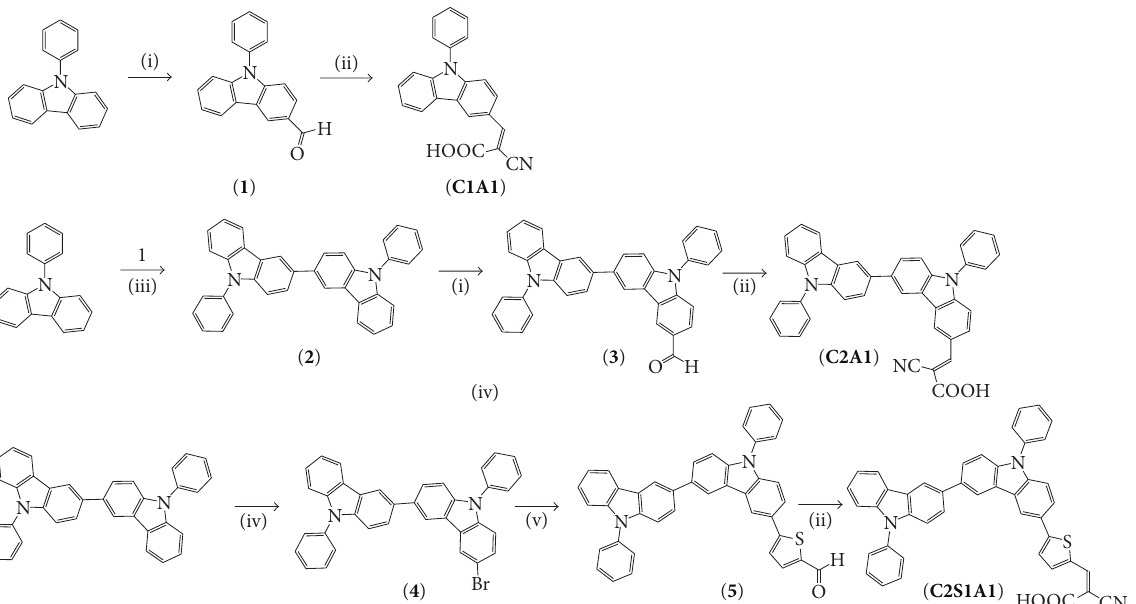
Scheme 1: Synthetic procedure of organic dyes. (i) DMF, POCl 3 , and 1,2-dichloroethane, reflux; (ii) cyanoacetic acid, piperidine, and CH 3 CN, reflux; (iii) FeCl 3 , CHCl 3 , and RT; (iv) Br 2 and AcOH; and (v) DME, H 2 O, K 2 CO 3 , and 5-formyl-2-thienylboronic acid,